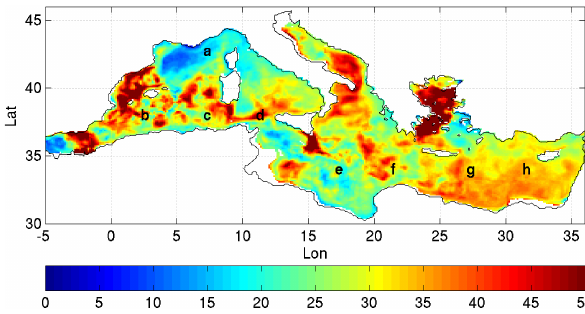
Figure 5. Map of the mean annual range of alkalinity for the surface layer (0–50m). Letters indicate the coordinates of the profiles given in Fig.